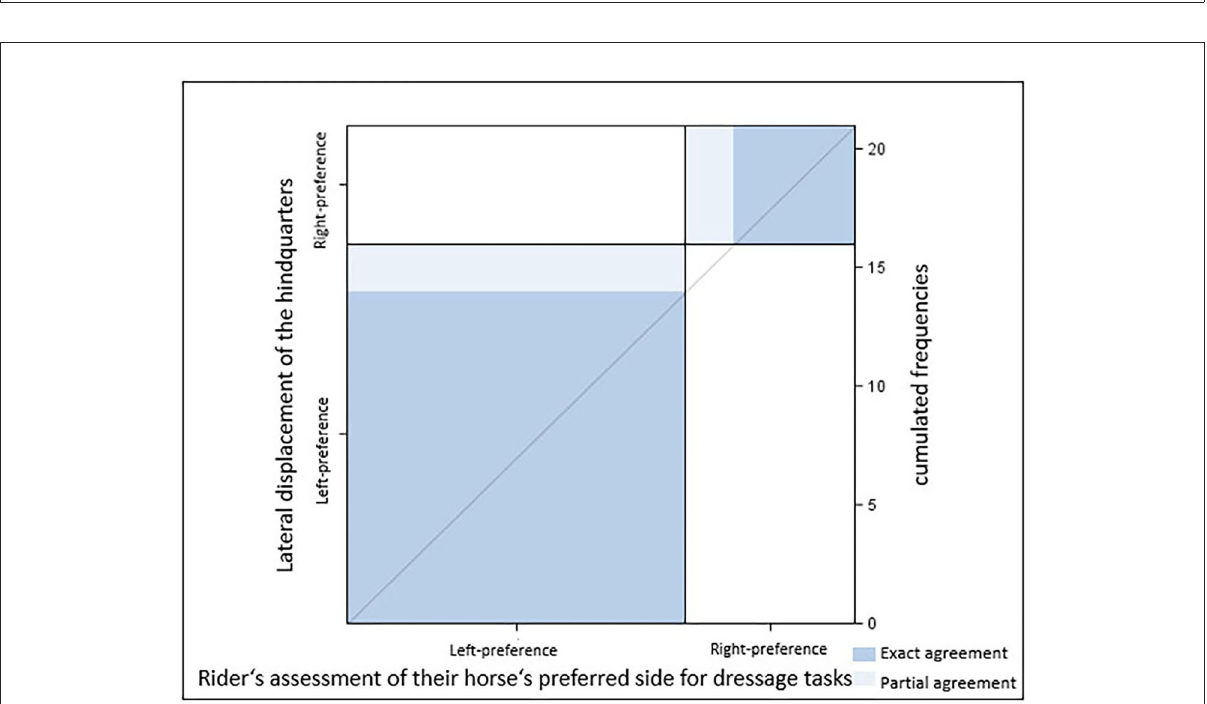
FIGURE4 Agreement between the direction of the lateral displacement of the hindquarters and the rider’s assessment of their horse’s preferred side for dressage tasks [ κ = 0.77 (0.47–1.00), p = 0.0003; Sample A.1 n = 21 horses]. Dark blue, exact agreement; light blue, partial agreement.